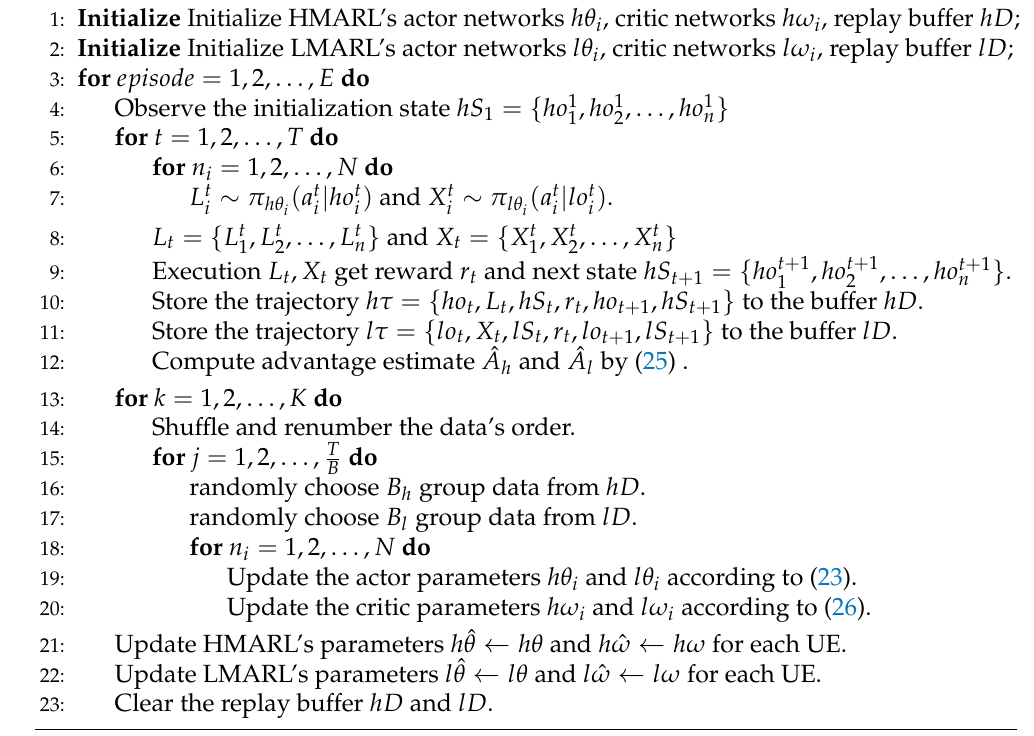
Algorithm 2 Proposed HDMAPPO